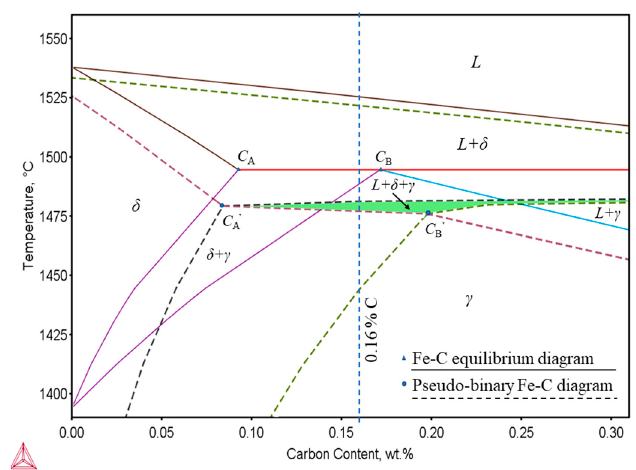
Figure 6. Fe–C equilibrium diagram and pseudo-binary Fe–C diagram of the 1.35 wt.% Al-TRIP steel.